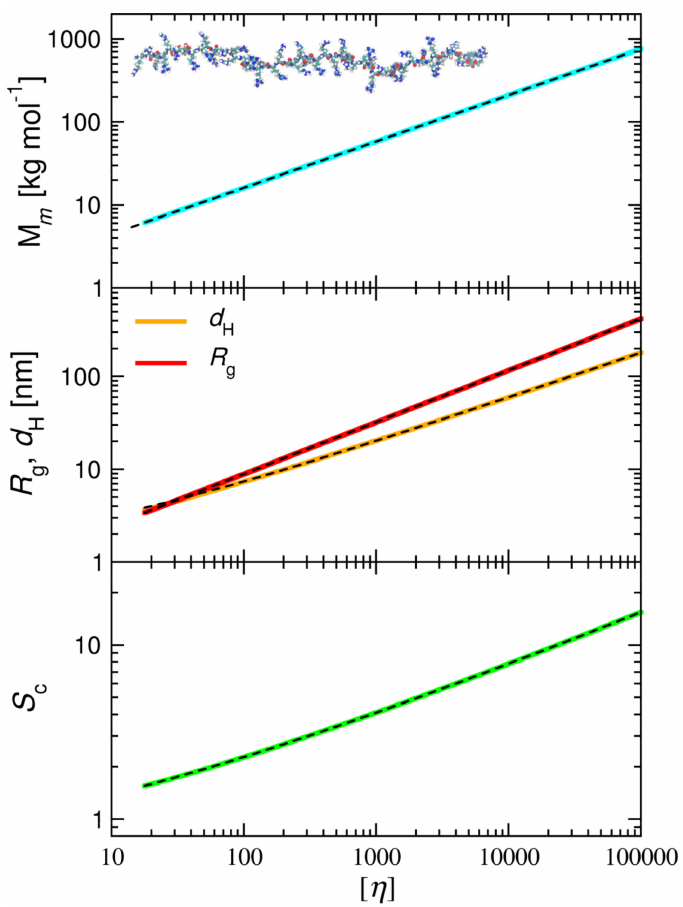
Figure 9. The molar mass ( M m ), the radius of gyration ( R g ), the hydrodynamic diameter ( d H ) and the sedimentation coefficient ( S c ) of P-Arg solutions vs. the intrinsic viscosity ([ η ]) in the limit of low ionic strength; theoretical results calculated from Equations (10), (11), (13) and (14). The dashed lines present fits to Equations (16)–(19). The insets show the P-Arg molecule conformation derived from MD